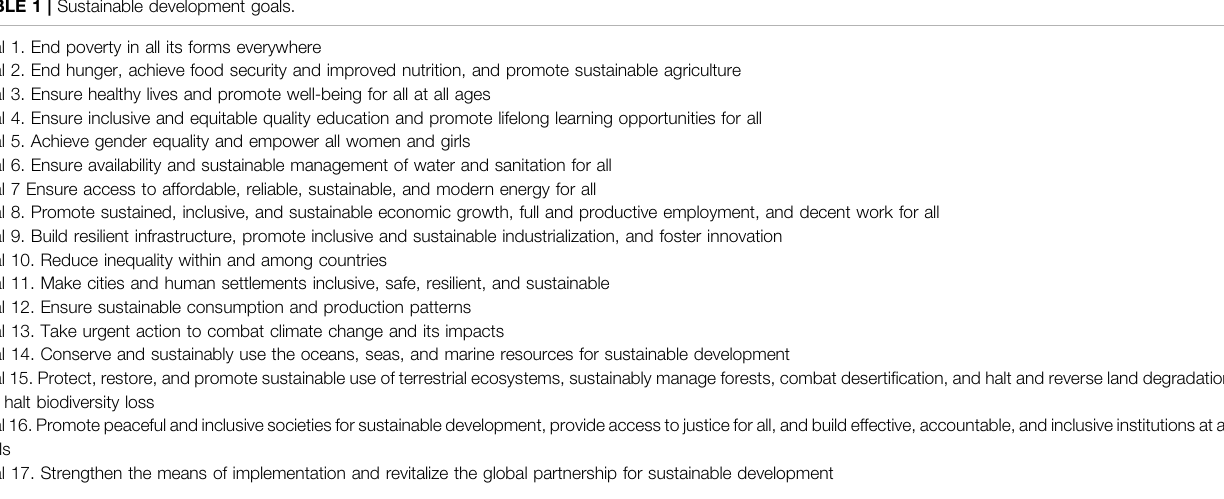
TABLE 1 | Sustainable development